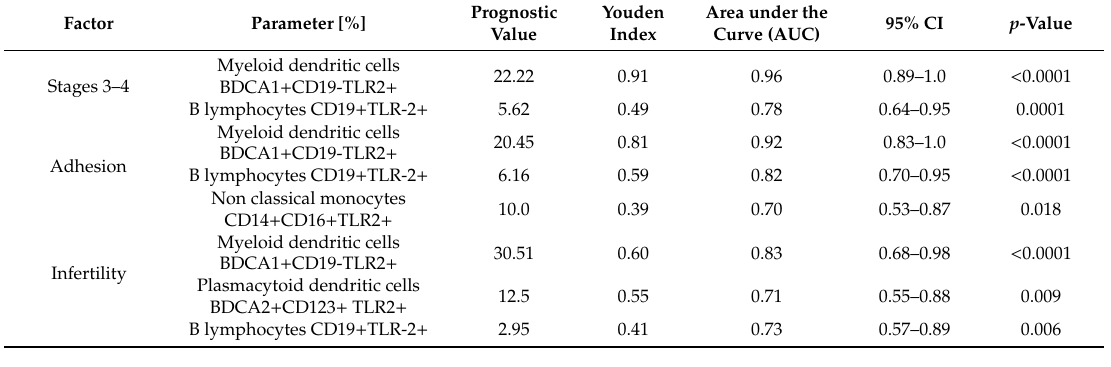
Table 4. Receiver operating characteristic (ROC) analysis to determine diagnostic accuracy in the di ff erentiation of patients with endometriosis.